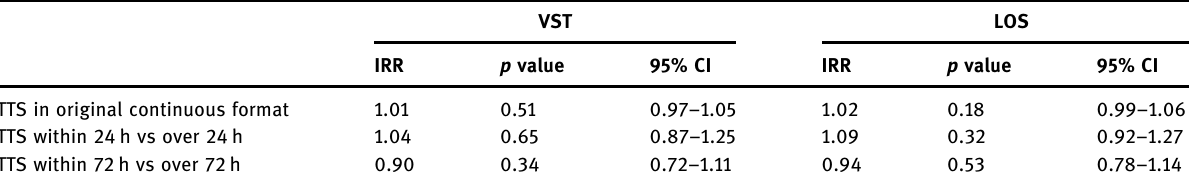
TTS, time of treatment start; LOS, length of hospital stay; VST, viral shedding time; IRR, incident rate ratio; CI, con fi